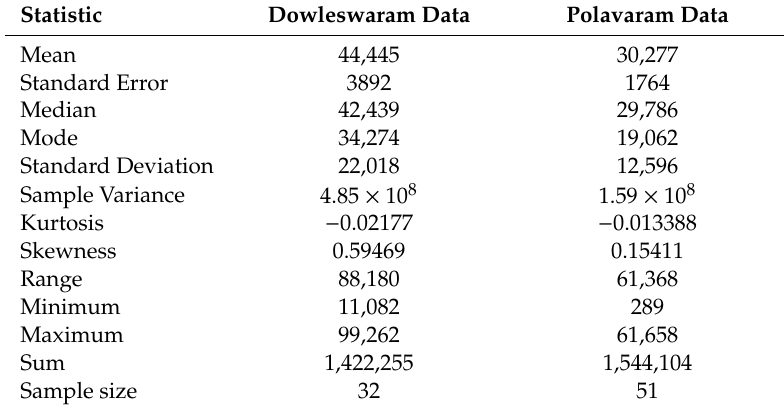
Table 4. Descriptive statistics for flood discharge in Dowleswaram and Polavaram (S.I